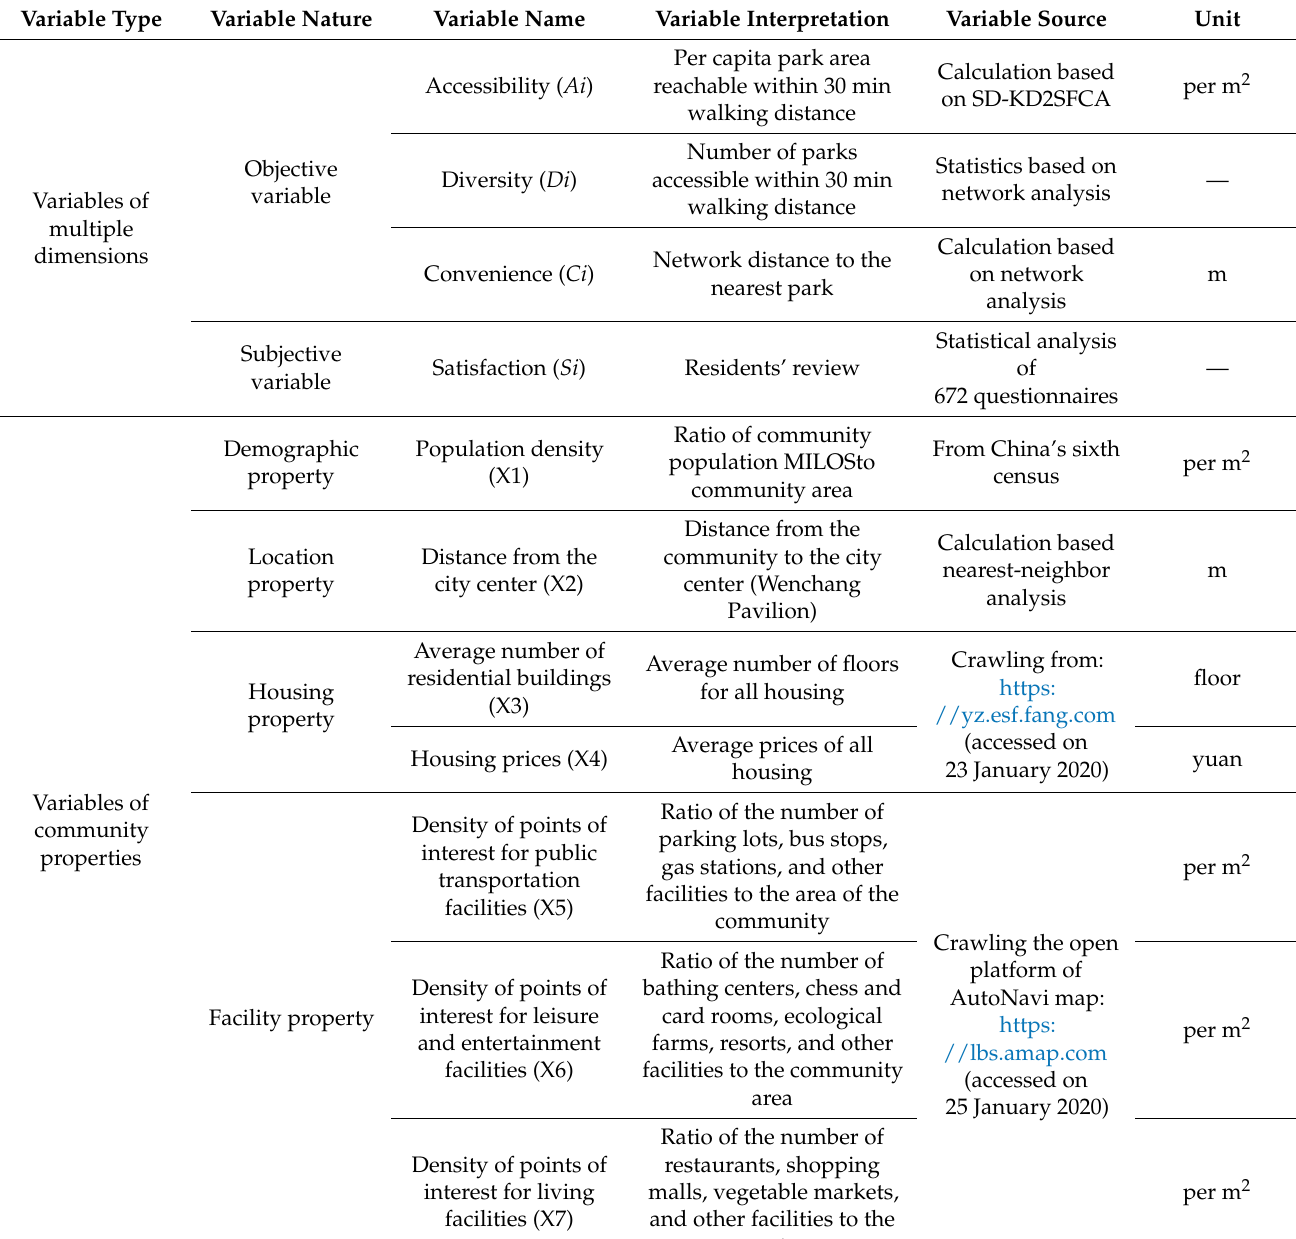
Table 2. Variable